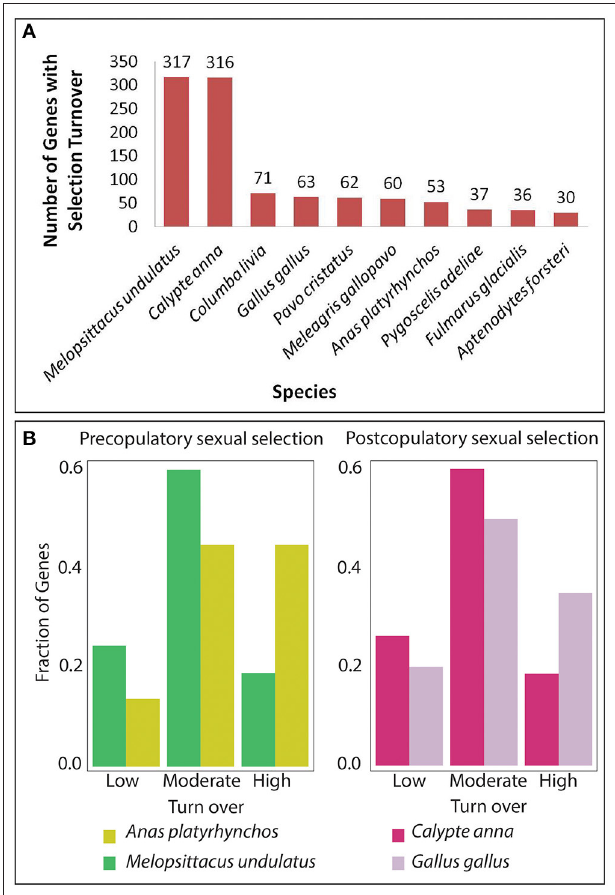
FIGURE 6 | Discrete correlation of selection turnover with sexual selection. (A) A bar plot for the number of genes with selection turnover for each of the selected 11 species. (B) Distribution of genes across Low (0–4), Moderate (5–8), and High ( > 8) turnover for contrasting species mallard duck ( Anas platyrhynchos ) with high pre-copulatory sexual selection vs. budgerigar ( Melopssitacus undulates ) with low pre-copulatory sexual selection and chicken ( Gallus gallus ) with high post-copulatory sexual selection vs. hummingbird ( Calypte anna ) with low post-copulatory sexual